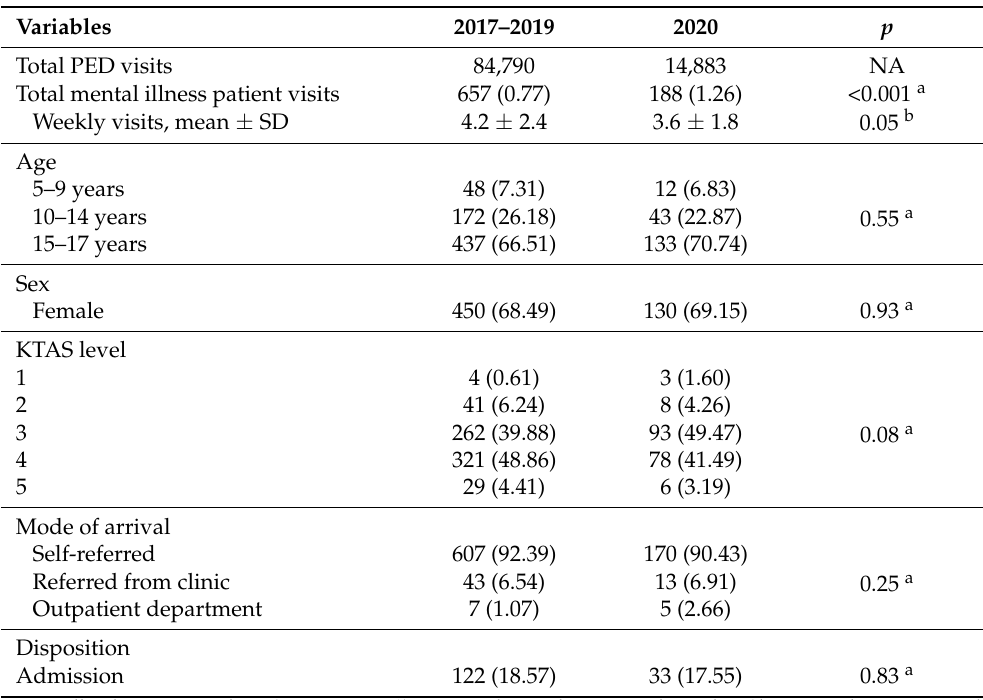
Table 1. Characteristics of 5–17-year-old patients with mental illness in the pediatric emergency